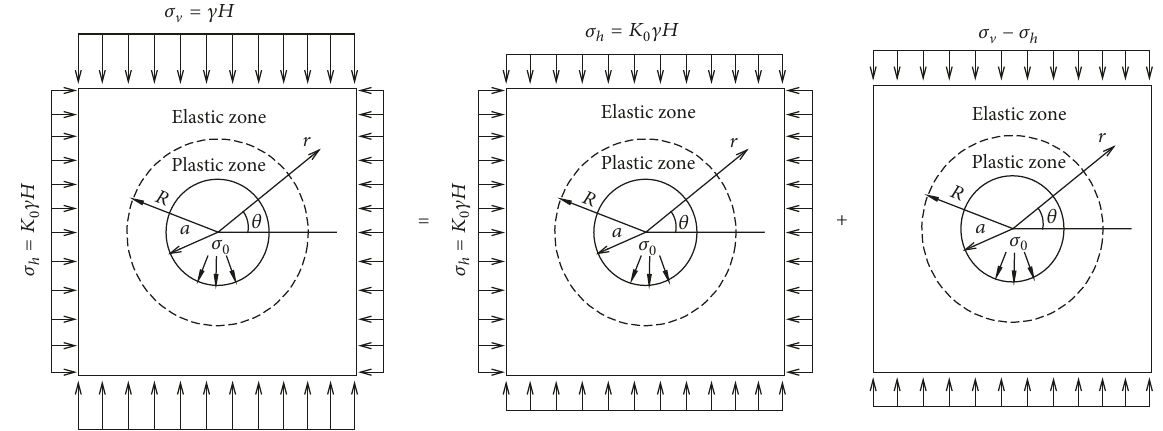
Figure 1: Initial stress field of shallow